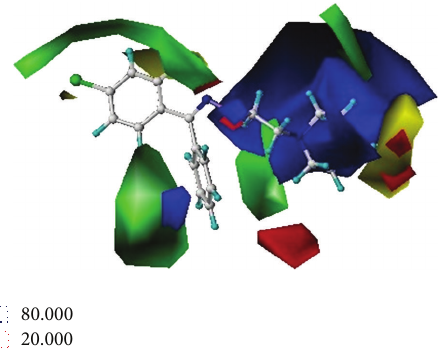
Figure 3: CoMFA contour map for Amaranthus mangostanus